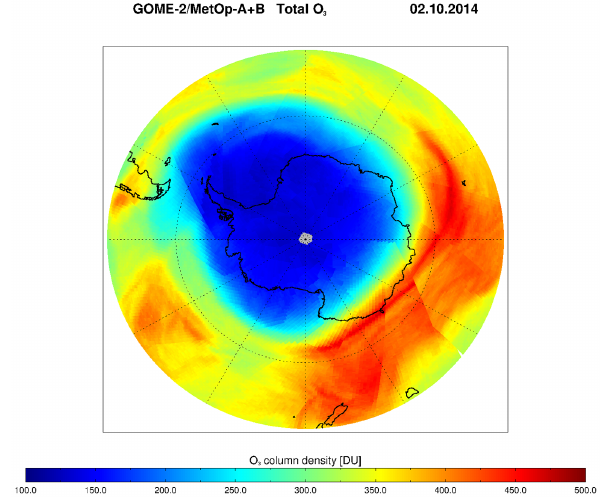
Figure 1. Total ozone map for 2 October 2014 based on data from GOME-2A and GOME-2B